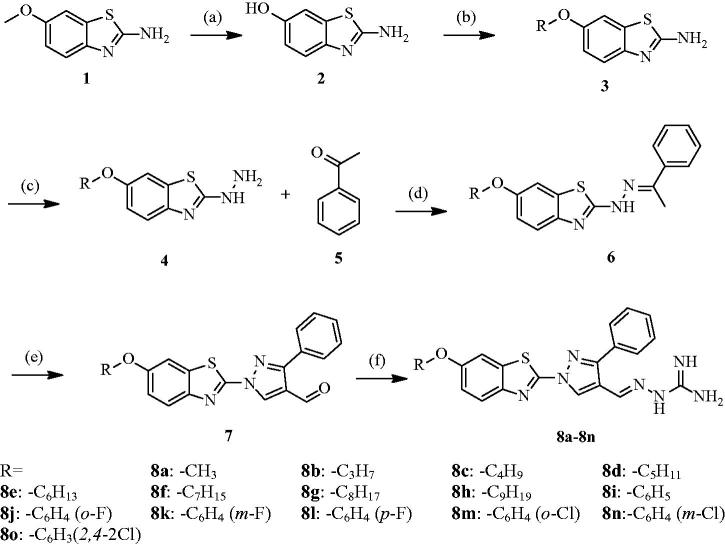
Synthesis of compounds 8a–8o. Reagent and conditions: (a) HBr (48% in H2O), reflux, 18 h; (b) RBr/RPhCH2Cl, CH3COCH3, K2CO3, reflux, 20 h; (c) 98%H2SO4, (CH2OH)2, 80 °C, 0.5 h, NH2NH2H2O, 140 °C, 5 h; (d) EtOH, AcONa, reflux, 1 h; (e) POCl3, DMF, 55–60 °C, 5 h; (f) aminoguanidine bicarbonate, EtOH, 60–70 °C, 8–12 h.